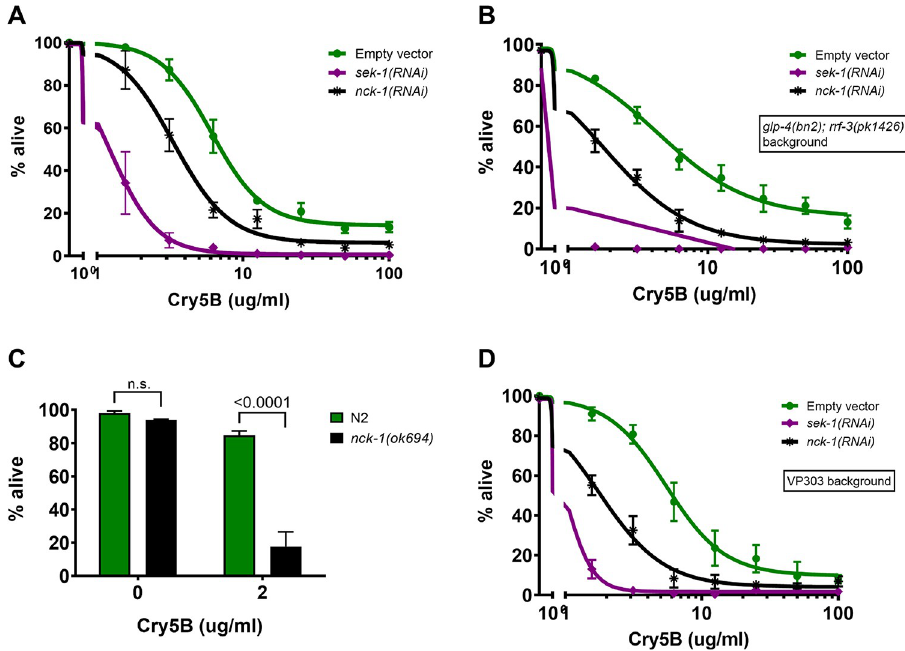
Fig 1. nck-1 loss sensitizes C . elegans to Cry5B. (A) Wild-type N2, (B) glp-4(bn2); rrf-3(pk1426) , or (D) VP303 (intestine-specific RNAi) C . elegans were grown from the L1 to L4 stage on E . coli expressing the indicated RNAi, then transferred to liquid culture with purified Cry5B for 6 days, then assayed for survival. (C) Wild-type N2 or nck-1 (ok694) null L4s were grown on OP50 E . coli until the L4 stage before being subjected to the same experiment. All data show the mean of three experiments. Error bars here and in other figures represent the standard error of the mean (SEM). Each data point is the average of three independent experiments with three wells/experiment (n = 25–34 worms/well).